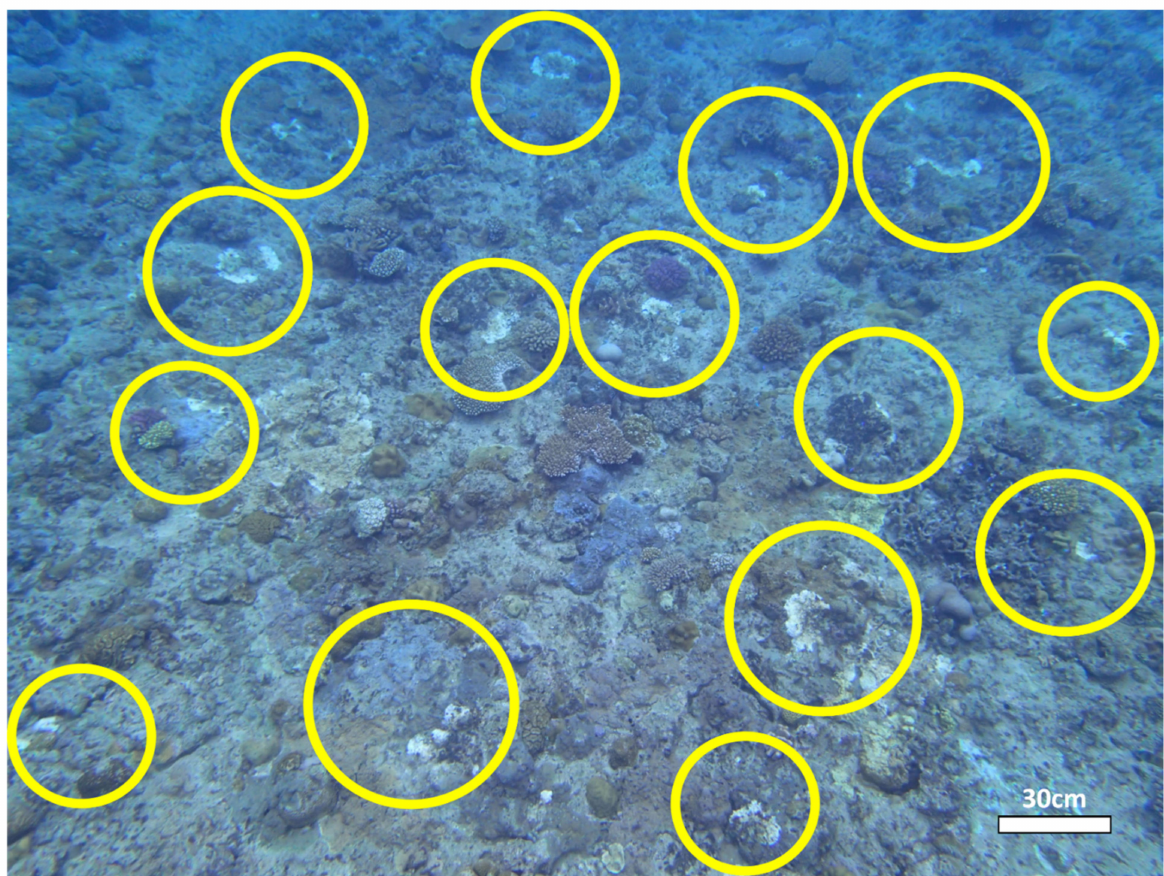
Figure 7. BBD occurrence on encrusting Montipora colonies within RE site S12 (south of Sesoko Island) during summer 2018 (yellow circles indicate BBD infected colonies). Scale: approximately 30